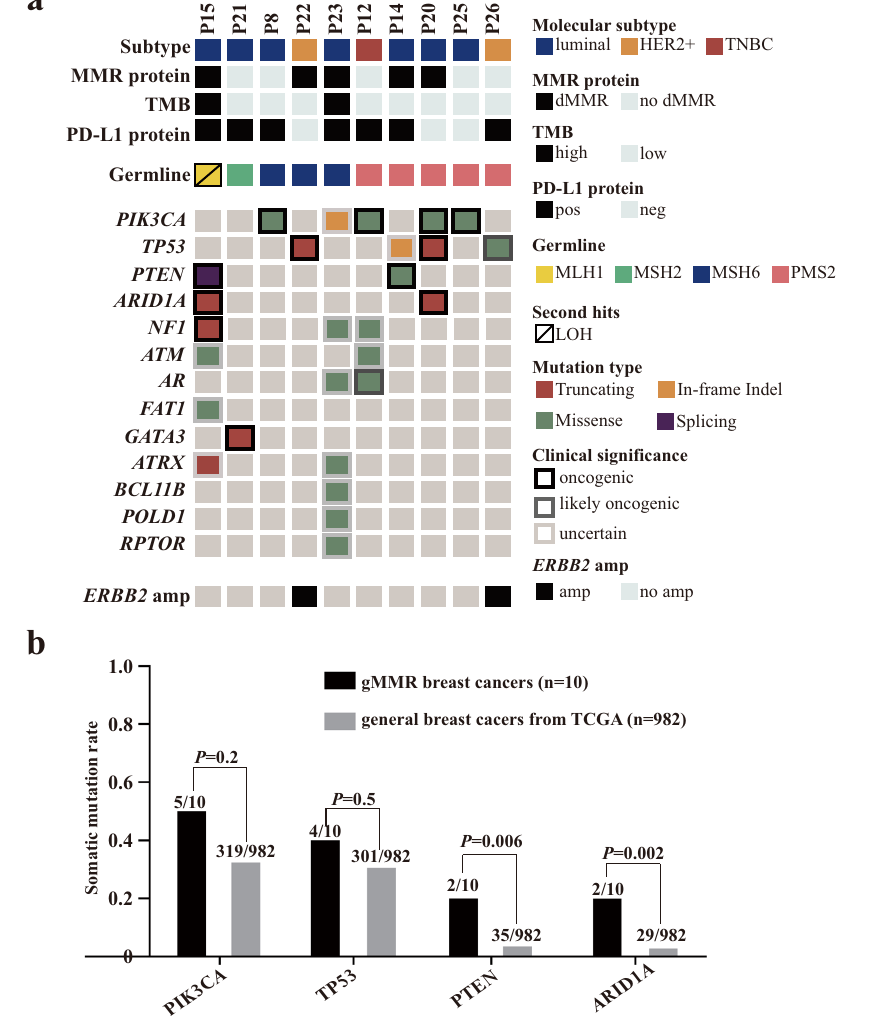
Fig. 3 Somatic mutation pro fi les of breast cancers from MMR variant carriers. a Landscape of frequently mutated genes in breast cancers from MMR variant carriers. b Comparison of the somatic mutation rates of PIK3CA, TP53, PTEN, and ARID1A between breast cancers carrying MMR germline variants and general breast cancers. Data are analyzed for statistical signi fi cance using Fisher ’ s exact test. Two-sided P values < 0.05 were considered to be statistically signi fi